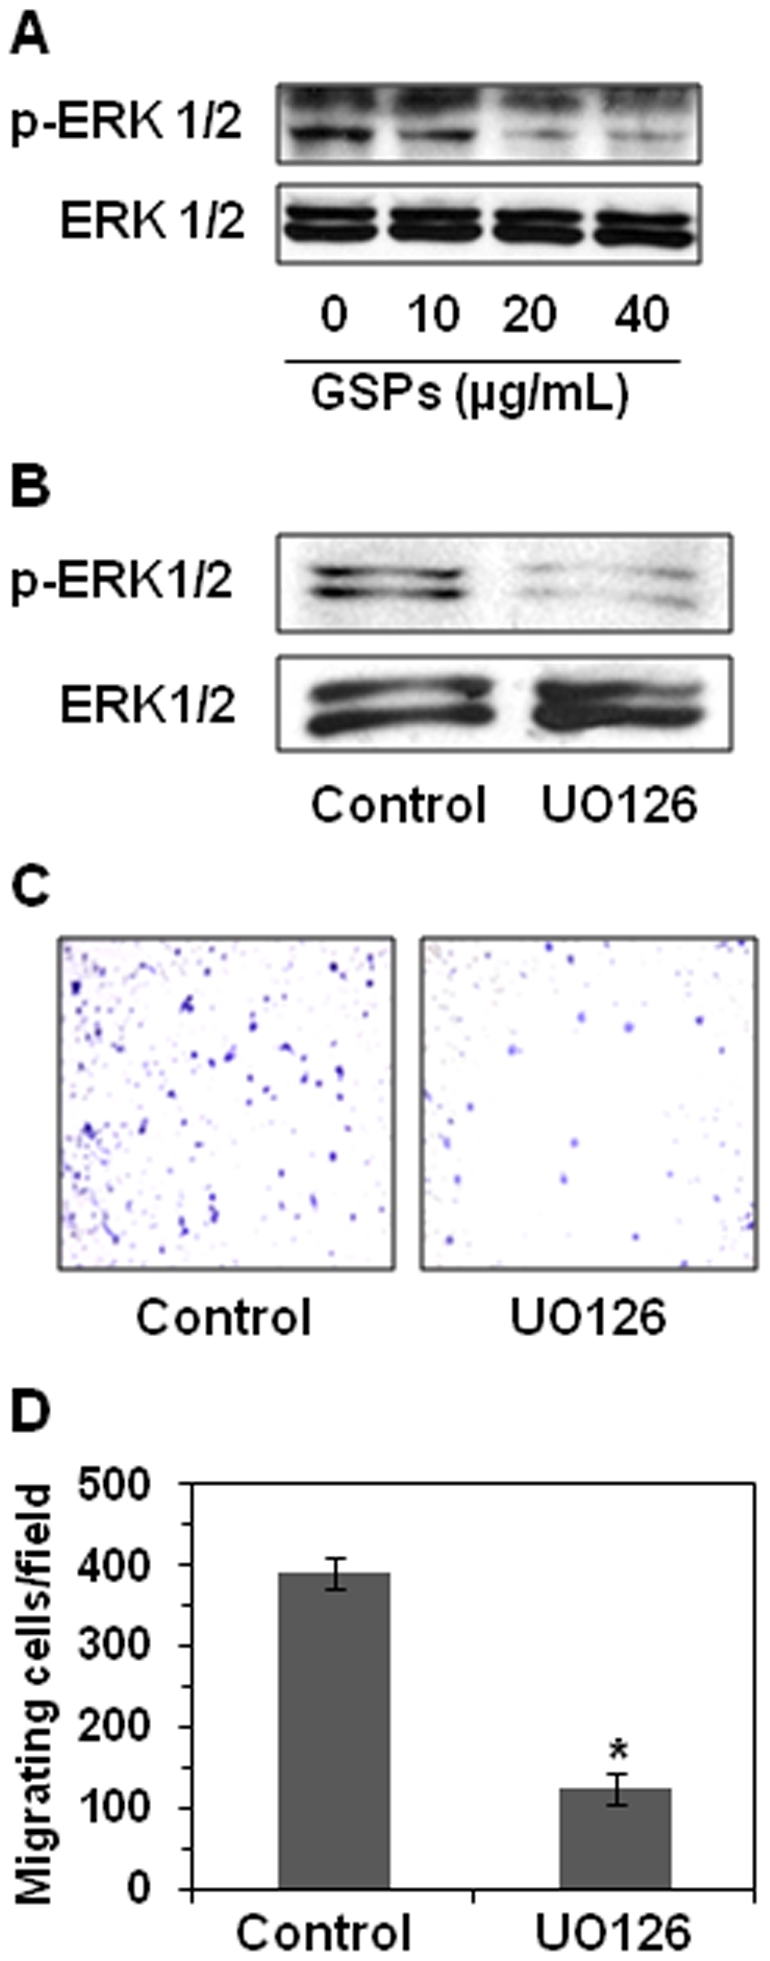
Both GSPs and MEK inhibitor (UO126) inhibit OSC19 cell invasion by reducing activation of ERK1/2.(A) GSPs inhibit the activation of ERK1/2 in OSC19 cells in a dose-dependent manner. OSC19 cells were treated with indicated concentrations of GSPs for 48 h, the cells harvested and whole cell lysates subject to western blotting using antibodies specific for total ERK1/2 and phosphorylated ERK1/2. (B) Similarly, the treatment of OSC19 cells with UO126, a MEK inhibitor, (80 µM) for 48 h inhibited the activation of ERK1/2 in cells as determined by western blot analysis. Representative blots are shown from three separate experiments. (C) OSC19 cells were treated with UO126 (80 µM) for 48 h and cell invasion assessed as described in Figure 1. Crystal violet staining of the membrane indicated that UO126 inhibited the invasive potential of cells as compared to non-UO126-treated control cells. (D) The data on cell invasion are summarized and expressed as the mean number of invasive cells±SD/microscopic field, magnification: ×10. Experiments were repeated two times. Significant difference versus control *
P<0.001.